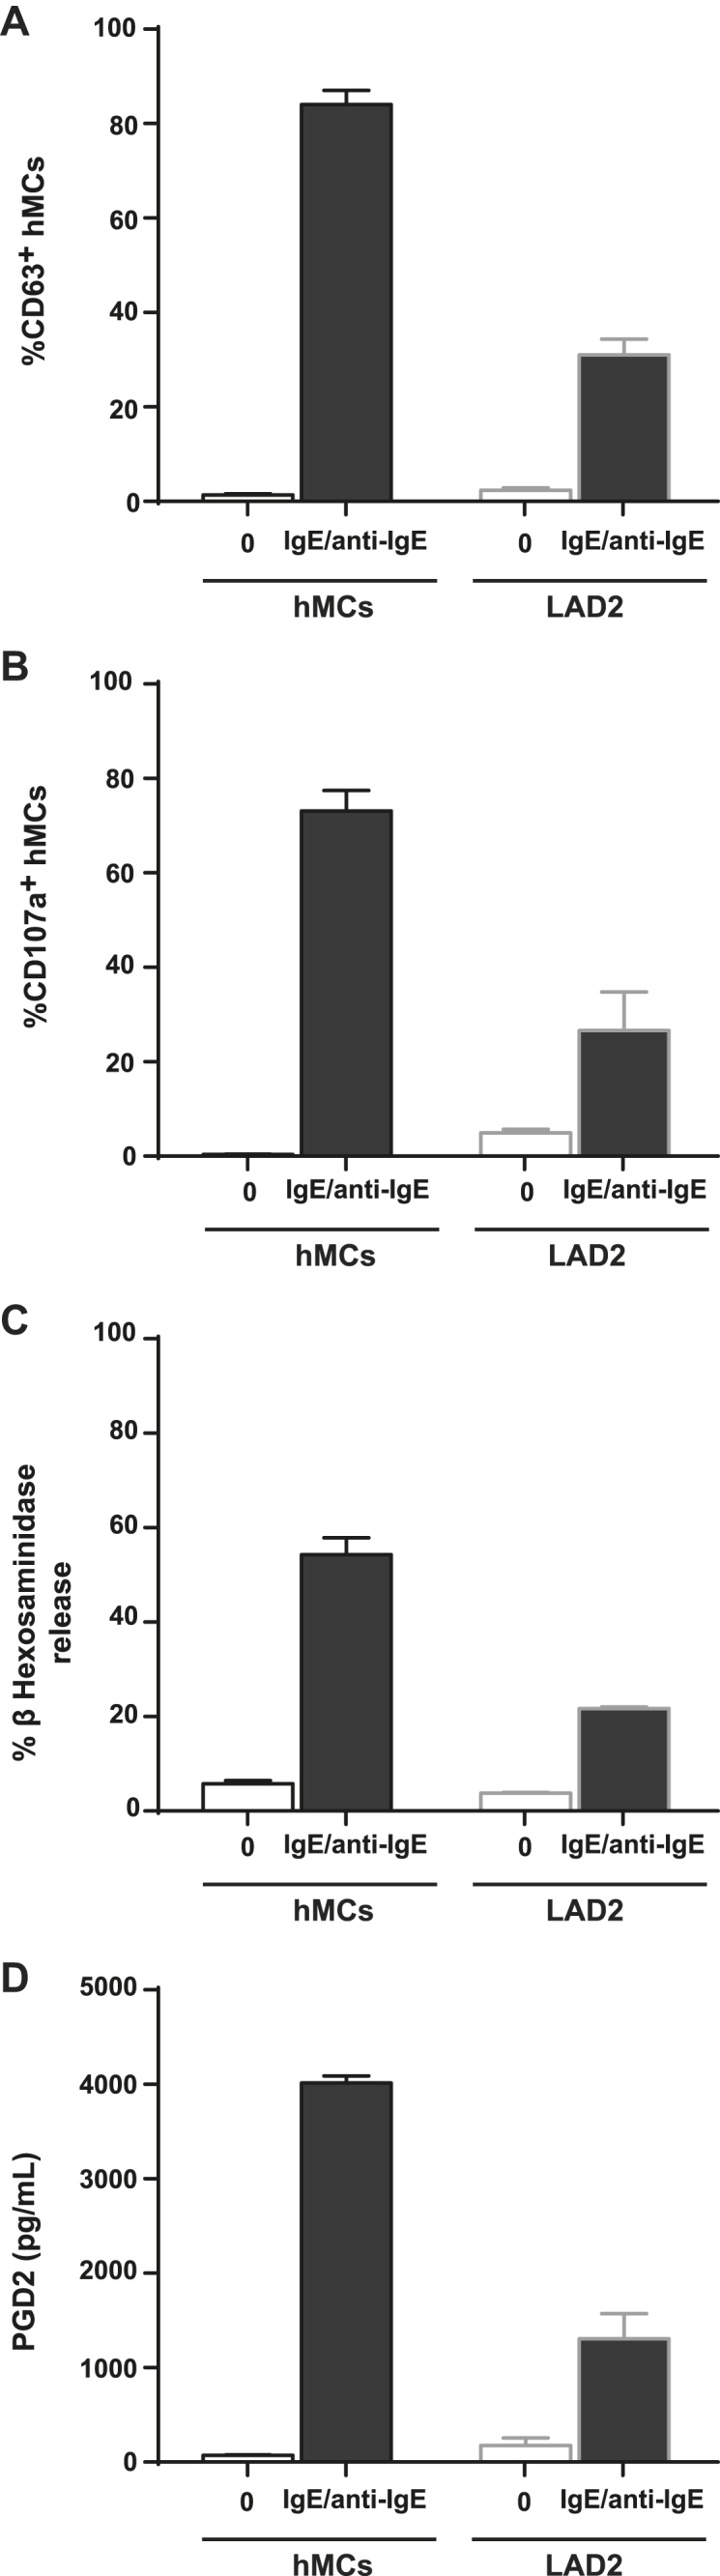
hMCs are more susceptible to IgE-mediated degranulation than LAD2 cells. hMCs were sensitized overnight with 1 μg/mL human IgE washed and either left untreated (0 μg/mL) or exposed for 1 hour to anti-IgE (10 μg/mL). A and B, hMC degranulation was measured based on CD63 (Fig E3, A) and CD107a (Fig E3, B) surface staining and analyzed by using flow cytometry. C, β-Hexosaminidase levels were measured in cell pellets, as well as in supernatants. Percentage of β-hexosaminidase release is shown. D, PGD2 levels were measured in supernatants. The assay was performed with pooled hMCs from at least 3 different healthy donors.